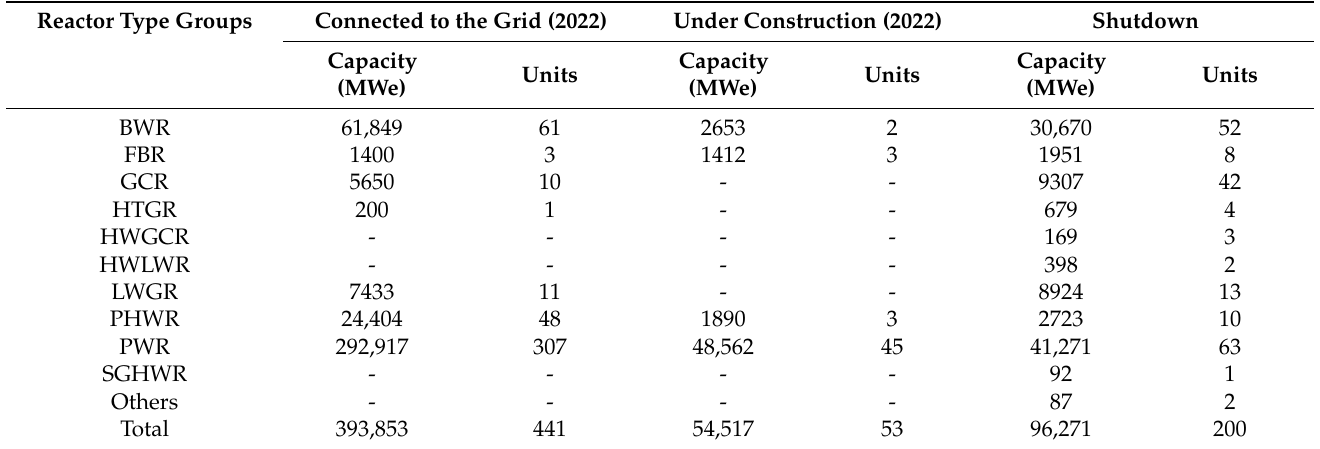
Table 2. Global state of nuclear power plants by reactor type in 2022 [20].